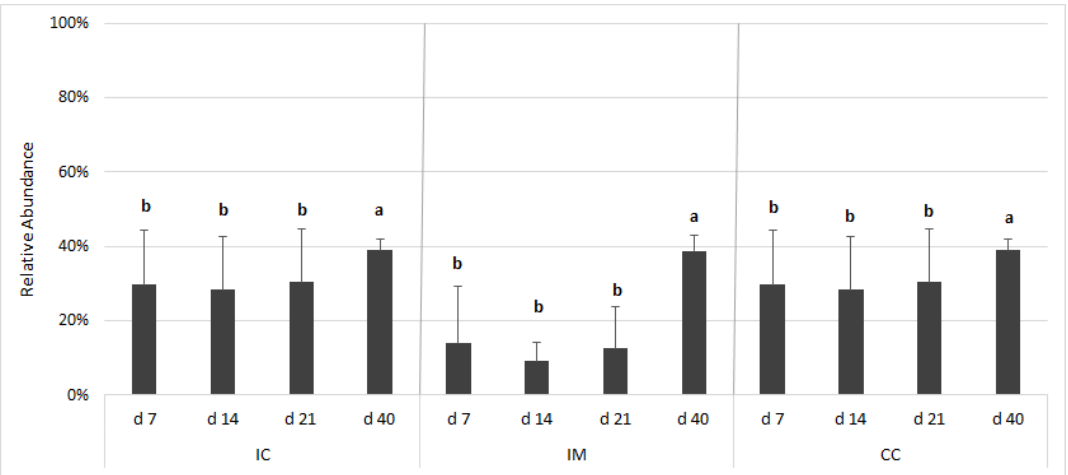
Figure 6. Relative abundance of potentially pathogenic bacteria according to BugBase analysis based on the 16S rRNA gene sequencing dataset. The outcome was grouped according to the gut segments and age. Gut segments were ileal chymus (IC), ileal mucosa (IM), and caecum chymus (CC). The relative abundance is presented on the y-axis, which is calculated by closed/open OTU picking ratio. Differences between groups were assessed using Mann–Whitney–Wilcoxon test, with Benjamini–Hochberg false discovery rate (FDR) correction. FDR-corrected p -values below 0.05 were considered significant. a, b: Averages with different letter marks differ significantly (FDR p < 0.05).